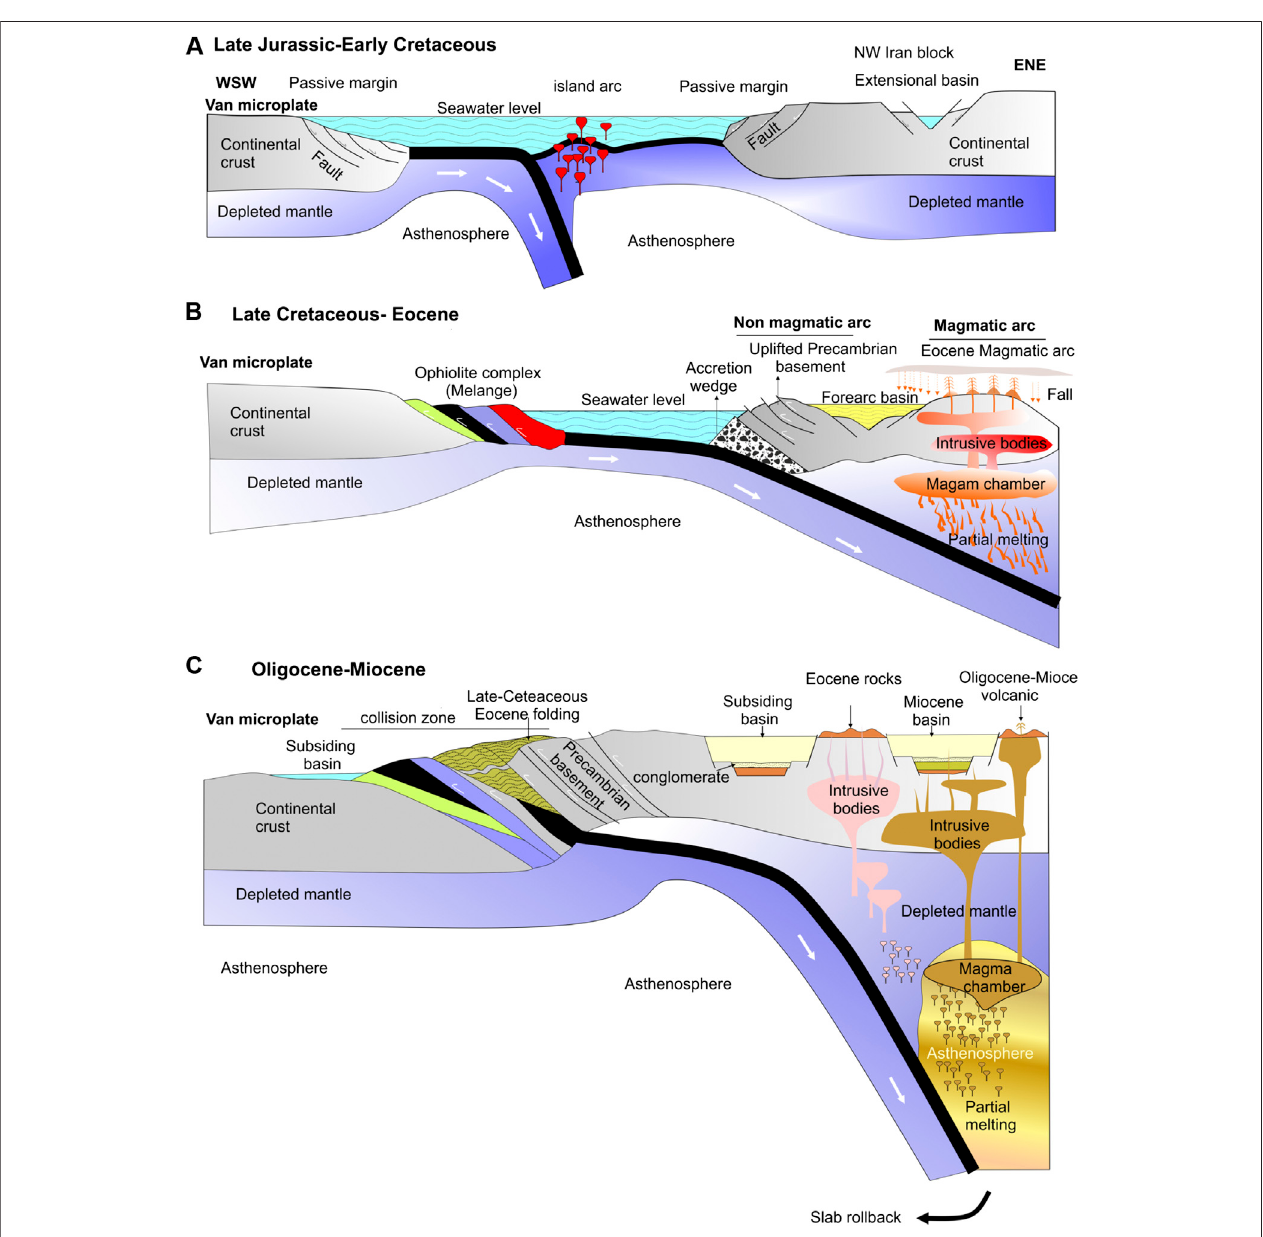
FIGURE 12 | Schematic tectonic model for the development of the magmatic arc from the Jurassic to the Oligocene-Miocene in the northwestern Iran block. (A) Development of the intraoceanic arc system in the Late Jurassic-Early Cretaceous periods. (B) Obduction of the Piranshahr-Khoy ophiolite complex over the Van microplatepassivemargin.SubductionofthenorthernbranchoftheNeotethysbeneaththenortherncontinentintheLateCretaceous-Eoceneledtothedevelopmentof nonarc and arc magmatism and an Eocene forearc basin. (C) Collison of the Van microplate and NWIA, followed by the obduction of the Precambrian basement. Fragmentation oftheEocenemagmaticbelt,thedevelopmentofinterarcbasins, injection, andtheeruptionofMiocenemagmaticrocks.Theseprocessesoccurreddue to oceanic rollback after collision in the